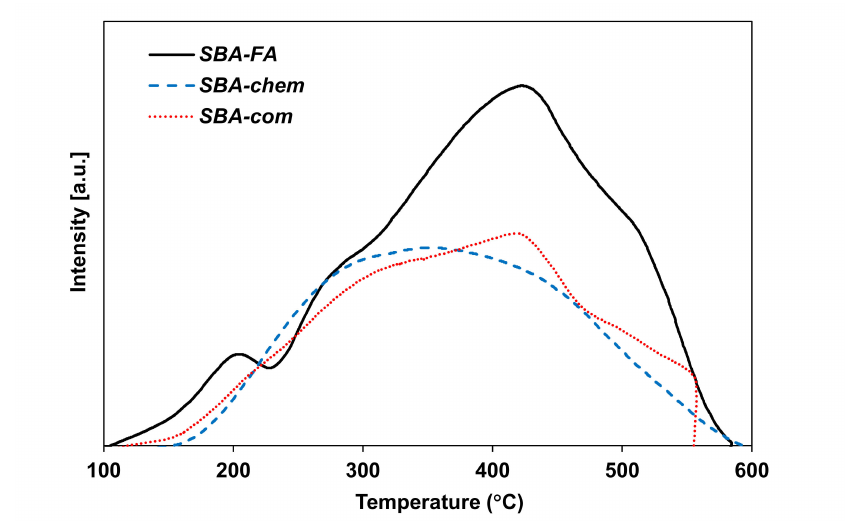
Figure 5. The ammonia temperature-programmed desorption (NH 3 –TPD) profiles of SBA-15 catalysts.